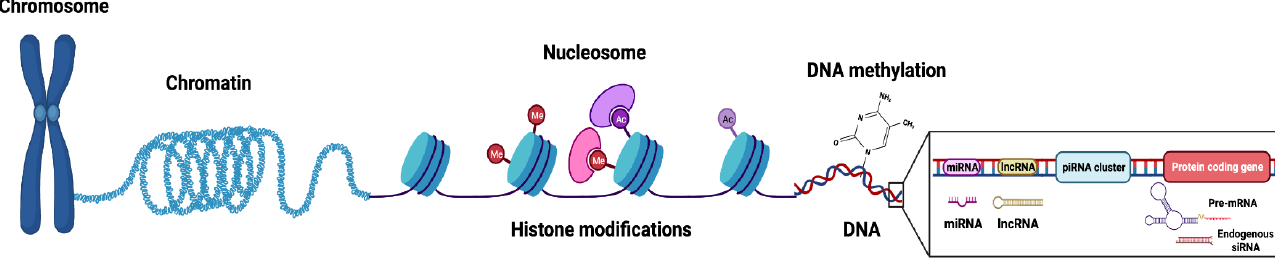
Figure 1. Graphical representation of chromatin structure and primary epigenetic mechanisms (histone modifications, DNA modifications, and non-coding RNA regulation) that regulate gene expression. The nucleosome, composed of DNA wrapped around an octamer core of histone proteins, is the functional unit of chromatin. Histone modifications involve numerous post-translational modifications, mainly targeting amino acid residues of N- terminal tails of the histones. DNA modifications refer to covalent modifications of the DNA at position 5 ′ of cytosine in CpG dinucleotides and are mainly facilitated by a family of enzymes known as DNA methyltransferases (DNMTs) or ten-eleven translocation (TETs) demethylases. Non-coding RNAs (ncRNAs), which do not encode proteins, can be subcategorized based on their size into long (lncRNAs, >200 nucleotides) and small (sncRNA, <200 nucleotides) non-coding RNAs with various regulatory roles in epigenetics (such as chromatin remodeling, gene transcription, mRNA degradation). sncRNAs include small inhibiting RNAs (siRNAs), microRNAs (miRNAs), and PIWI-interacting RNAs (piRNAs). Figure created with BioRender.com (accessed on 26 January 2023).